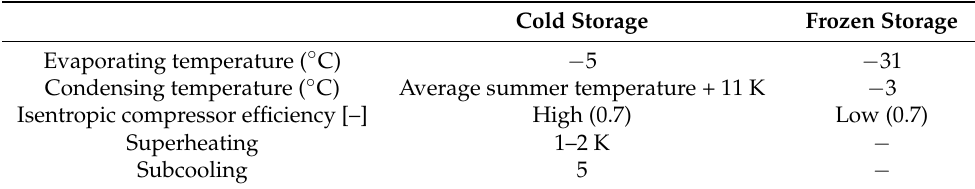
Table 3. The operating conditions of the refrigeration system. Cold Storage Frozen